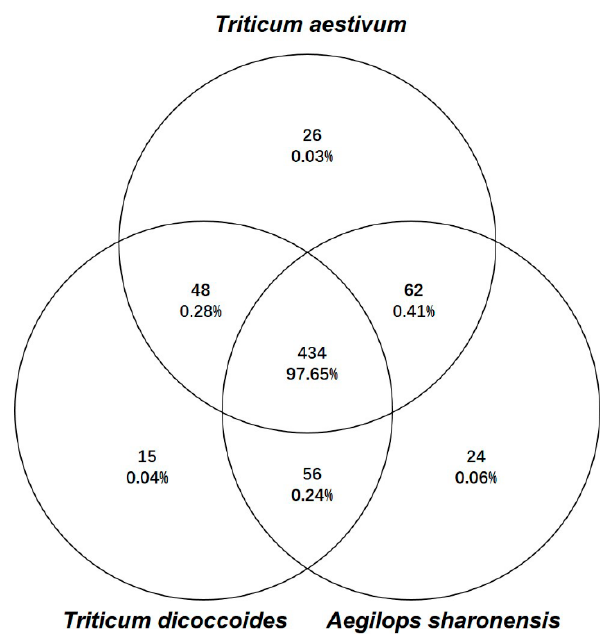
Figure 2. Shared and unique fungal taxa among the fungal endophyte communities (FECs) of the three plant species. The Venn diagram shows 665 taxa in core dataset with prevalence threshold of > 5. Percentage indicates relative abundance of corresponding group of taxa within the overall dataset covering all 1666 agglomerated taxa. In total, 1001 taxa that account for 1.28% of the reads did not meet the prevalence threshold and were removed from the core dataset.